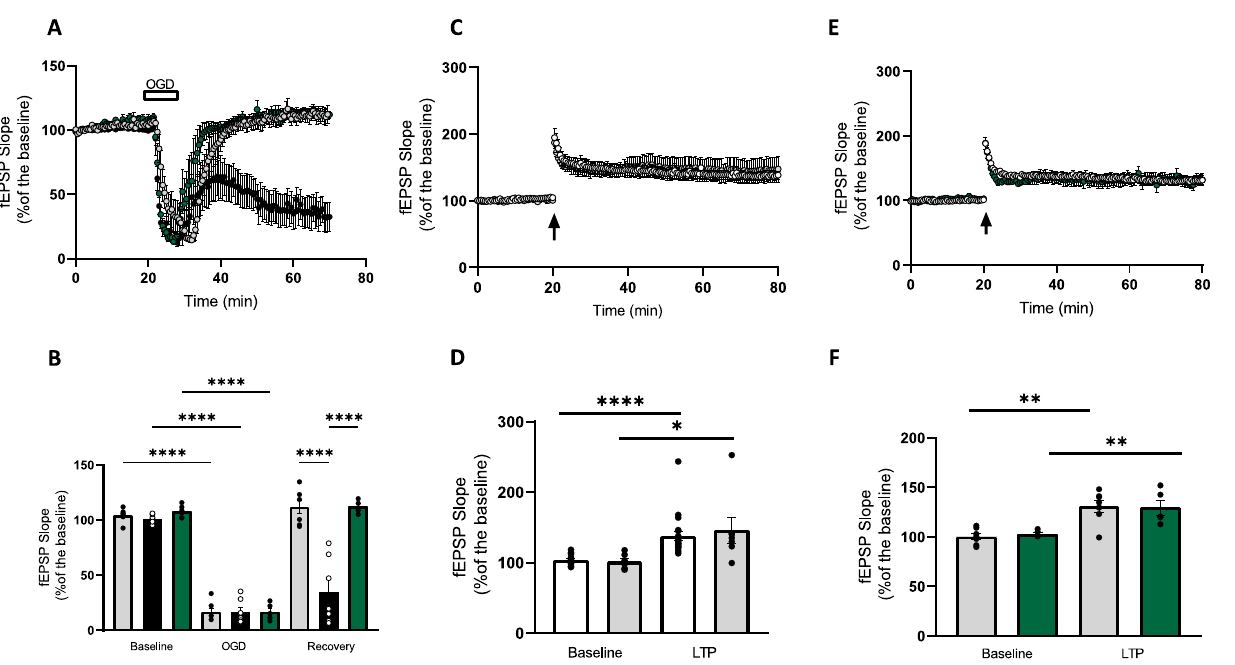
Figure 2. MnTMPyP does not affect synaptic transmission during OGD and post-ischemic LTP. ( A ) Timeline showing changes in CA1 fEPSP slope following a 10 min OGD episode for control (grey circles), MnTMPyP (25 µ M, black circles) and MnTMPyP (2.5 µ M, green circles). In the CA1, OGD gave rise to a maximum depression of fEPSP to 48.0 ± 10.0% of control and a recovery to 99.5 ± 10.1% ( n = 5). In slices pretreated with 25 µ M MnTMPyP, the OGD-induced depression of fEPSP was 16.4 ± 4.2%, with a recovery of 35.0 ± 11.4, n = 7 at 40 min post-OGD. OGD slices pretreated with 2.5 µ M MnTMPyP had similar depression of fEPSP but modulated the recovery after the ischemic insult (17.0 ± 3.4% and 113.0 ± 3.0%, respectively, n = 5, at 40 min post-OGD). ( B ) Bar charts summarising the data in A. Grey bars represent controls, black bars represent 25 µ M MnTMPyP and green bars represent 2.5 µ M MnTMPyP-treated group. ( C ) Time-course showing control LTP (white circles) and LTP post-10 min OGD (grey circles). HFS induced a stable LTP in control slices lasting 60 min (135.0 ± 6.1%, n = 27) with no difference compared to LTP induced in slices pre-exposed to OGD (131.0 ± 6.0%, n = 7). ( D ) Bar charts summarising the data in C. White bars control and grey bars post-OGD. ( E ) Time-course of fEPSP slope before and after HFS from control slices (grey circles) and 2.5 µ M MnTMPyP-pretreated slices (green circles). HFS was induced 40 min after the ischemic event. In control slices, the stimulation gave rise to a stable synaptic potentiation after 60 min (131.0 ± 6.0%, n = 7). In slices pretreated with 2.5 µ M MnTMPyP, the HFS induced a robust LTP with no significant difference compared to post-ischemia control LTP (129.5 ± 7.5%, n = 4). ( F ) Bar charts summarising the data in E. Grey bars represent controls and green bars represent post-2.5 µM MnTMPyP. In LTP experiments, baseline values were taken 5 min before HFS induction, LTP values were taken at 55 min after HFS. Arrow indicates timing of HFS. All data are expressed as mean ± SEM. * p < 0.05, ** p < 0.01, **** p < 0.0001.